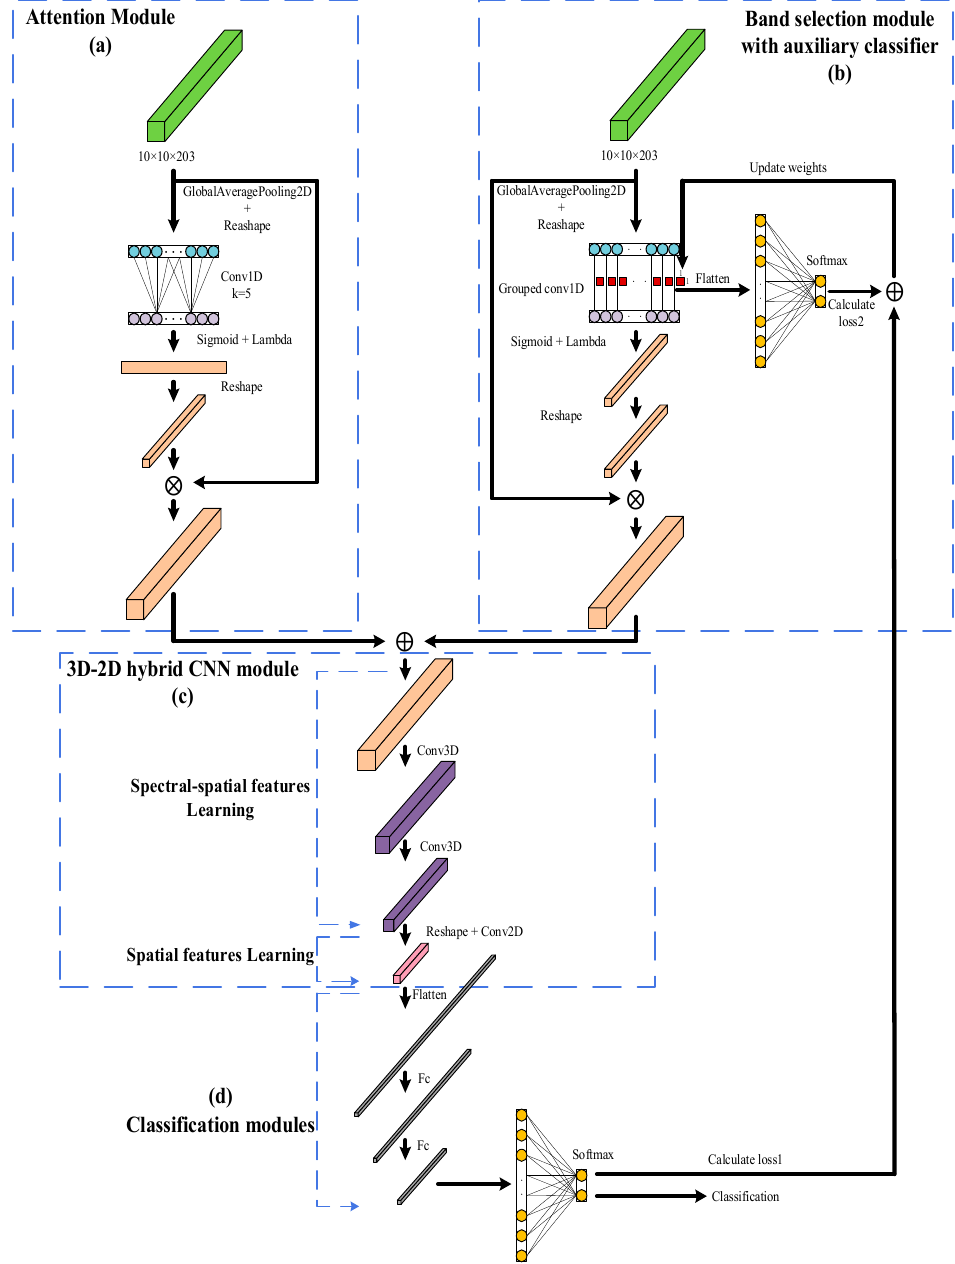
Figure 4. Y–Net architecture. ( a ) Attention module; ( b ) Band selection module with auxiliary classifier; ( c ) 3D–2D hybrid CNN module; ( d ) classification